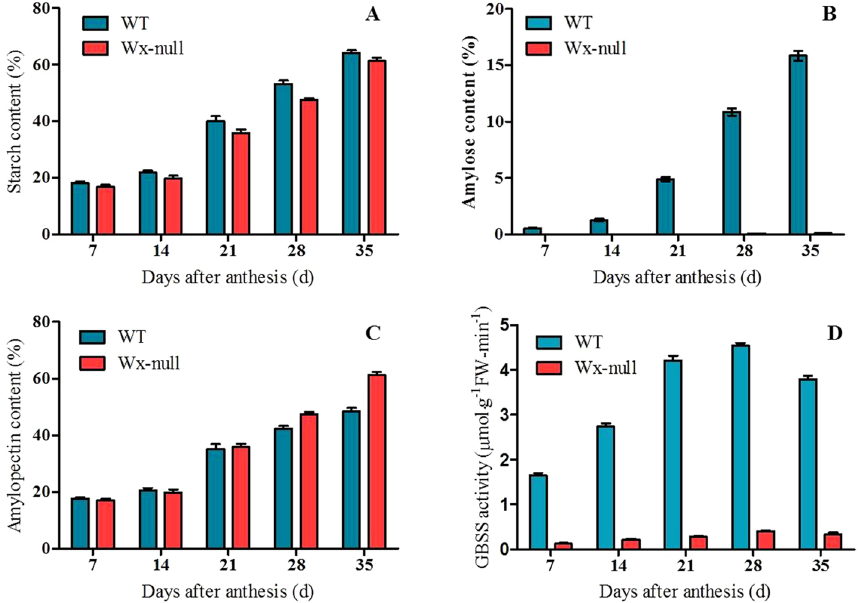
Figure 1. Total starch content, amylose content and GBSS I activity analysis. ( A ) Total starch content; ( B ) amylose content; ( C ) amylopectin content; ( D ) GBSS I activity. Error bars show SEM.